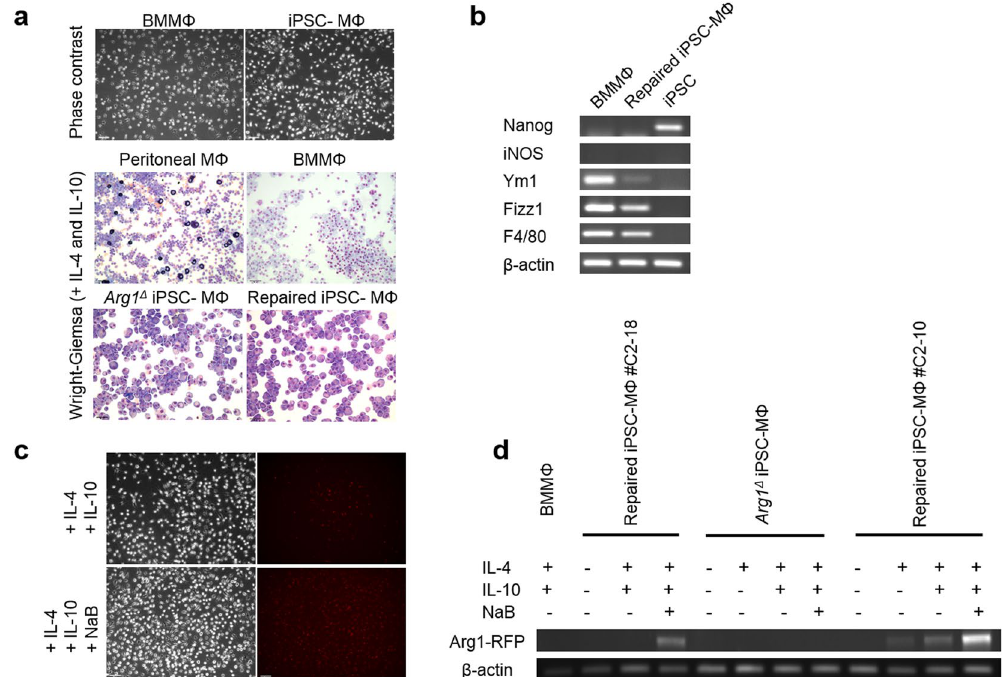
Figure 5. Characterization of iPSC-derived macrophages by assessing mRNA expression of macrophage phenotypic markers. ( a ) Phase contrast (upper panel) and cytocentrifuge preparations of macrophages for Wright–Giemsa staining (lower panels). The cells appear purplish and granular. 20x magnification. ( b ) RT- PCR analysis of macrophage marker genes in macrophages. Differentiated macrophages demonstrated M2-like characteristics. Expression of genes was normalized to β -actin. ( c ) RFP signal observed in the repaired iPSC- derived macrophages. ( d ) mRNA expression levels of Arg1-RFP in macrophages after treatment with IL-4, IL- 10, sodium butyrate (NaB) as assessed by